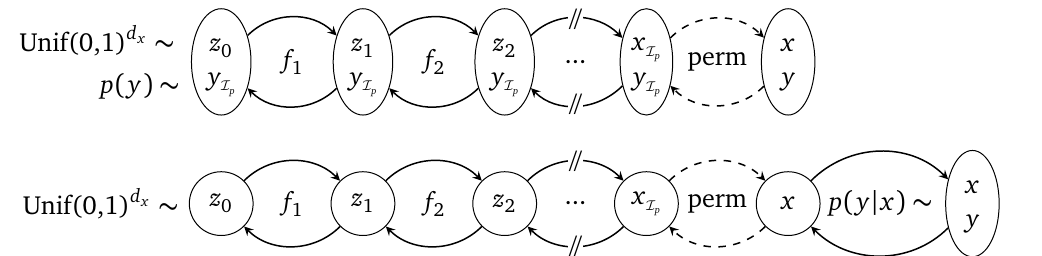
Figure 10: The factorized architectures described in section 3.5.3. The permutation transform can either be a stochastic permutation or a sort surjection, in which case the arrow in the inverse direction would be